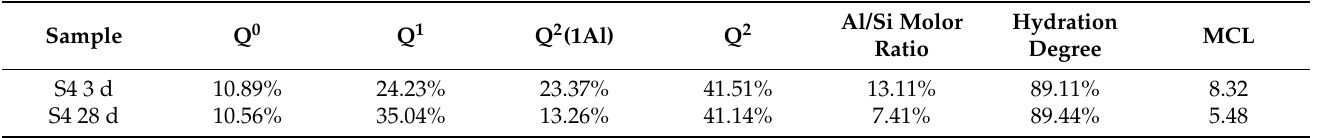
Table 6. Relative fractions, Al/Si ratio, and mean silicate chain length (MCL) obtained by the deconvolution of 29 Si MAS NMR